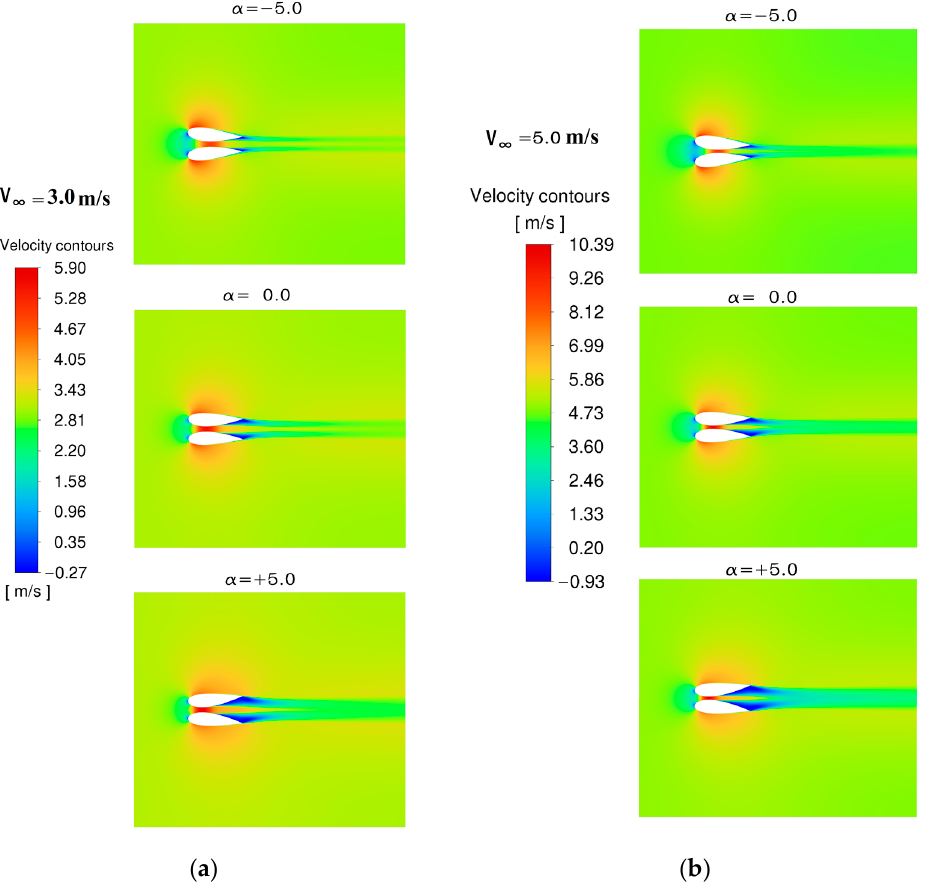
Figure 7. Velocity contours for different pitch angles with 30 cm gap ( a ) U ∞ = 3 m/s and ( b ) U ∞ = 5 m/s).